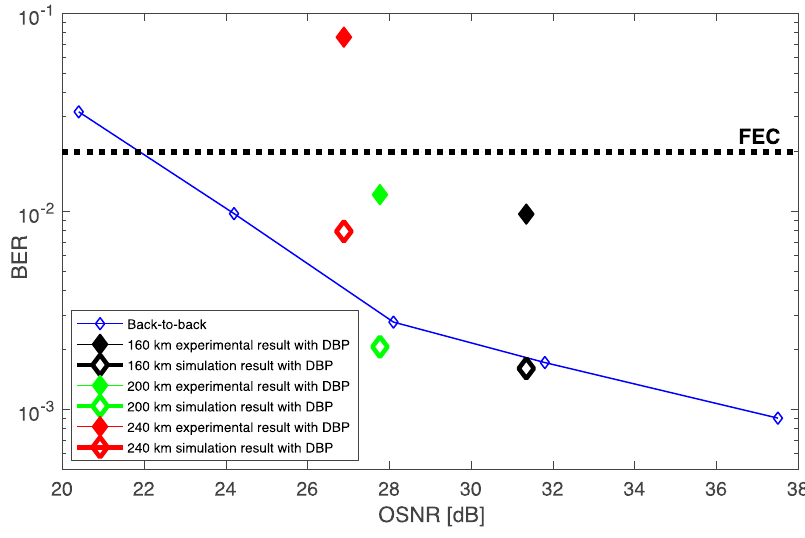
Figure 9. Comparison of optimal experimental and simulation results.